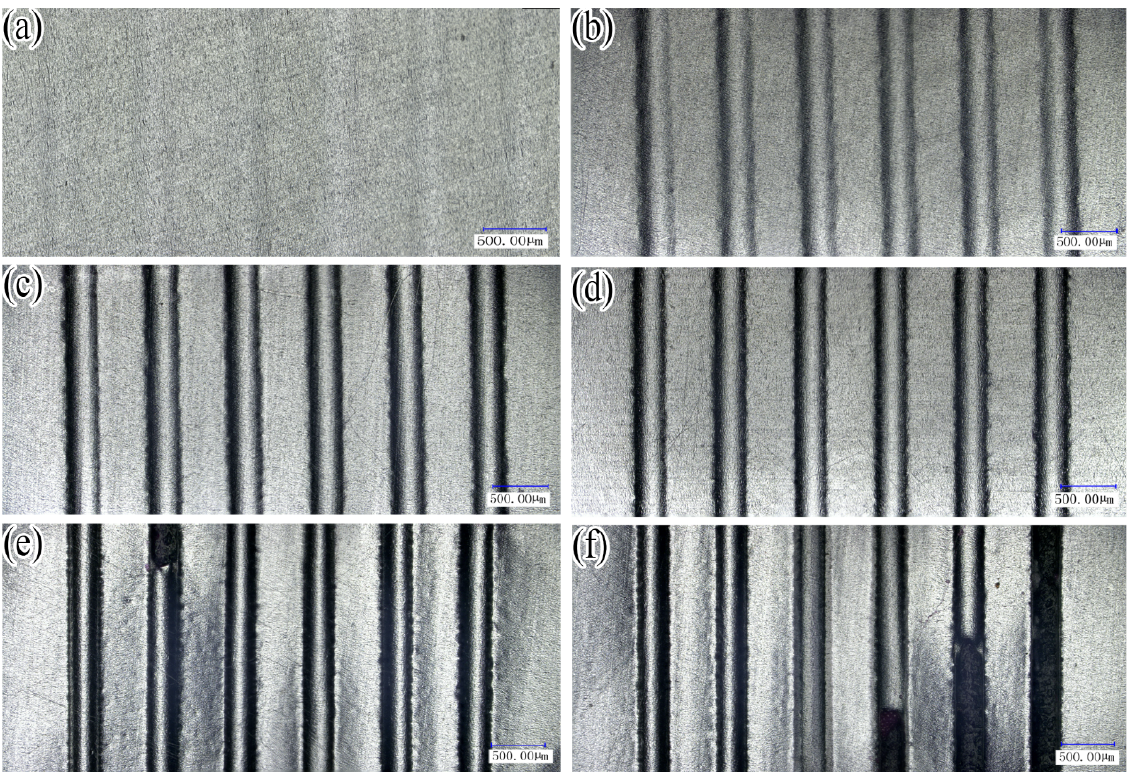
Figure 5. 2D topography of the metal sheet surfaces: ( a ) with the final load force 1180.27 N; ( b ) with the final load force 2019.06 N; ( c ) with the final load force 3038.06 N; ( d ) 5011.10 N; ( e ) 8063.37 N; ( f ) 9009.26